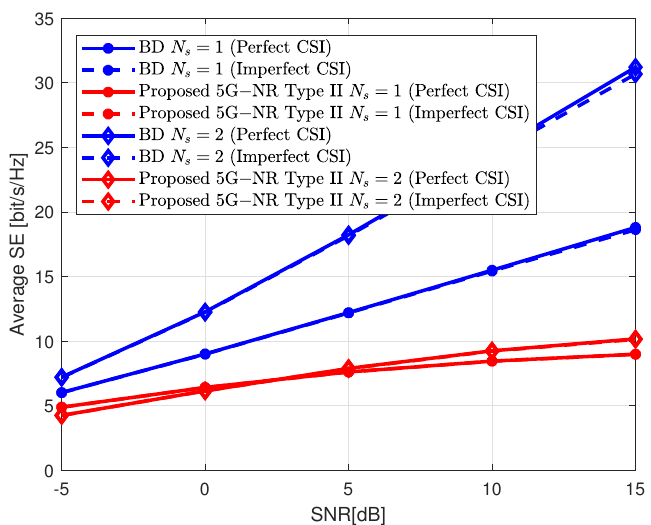
Figure 9. Average SE vs. SNR for MU-MIMO systems assuming 𝐾 = 2, 𝑁 𝑡 = 32, 𝑁 𝑟 = 4, and different values of 𝑁 𝑠 . The gNB is implemented assuming an ULA single-panel with 𝑁 1 = 16, and 𝑁 2 = 1. Imperfect CSI is also assumed with 𝜎 2 𝑒 = 10 − 3 .